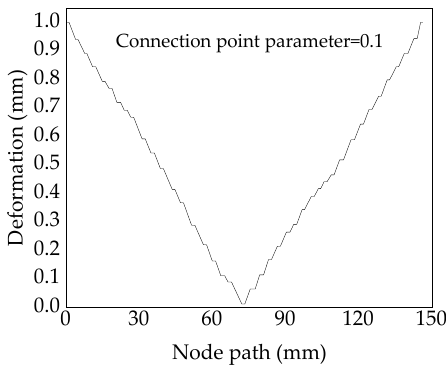
Figure 13. Deformation distribution of variable-angle laminates of [0 ± < 20 (0.1) 60 > ] 2s in the axial direction.